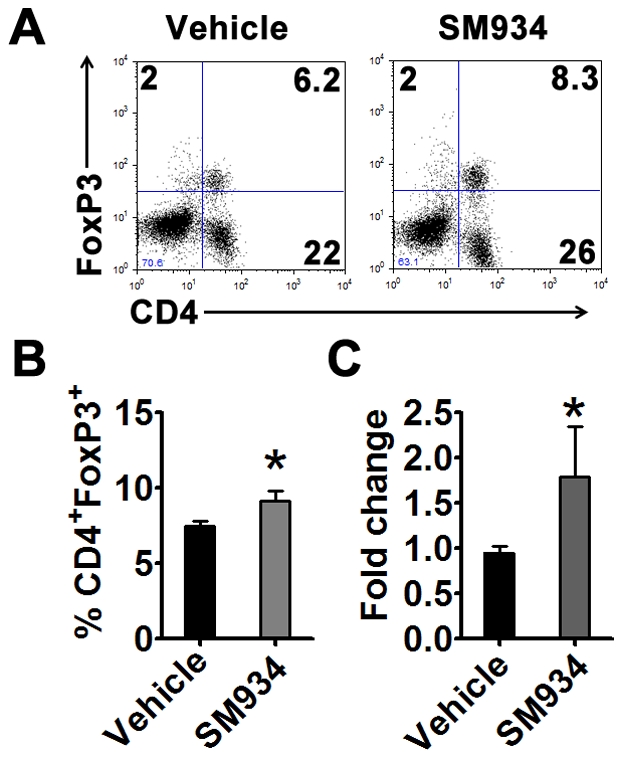
SM934 treatment induced the accumulation of Treg cells.At the termination of 3 months treatment, female NZB/W F1 mice in vehicle and SM934 (10 mg/kg) treated groups were randomly and averagely divided into 3 sub-groups. Spleens of each sub-group were pooled together. (A) Surface CD4 and intracellular FoxP3 expressions in splenocytes. (B) Statistical results of percentage of CD4+FoxP3+ population in splenocytes. (C) Real-time PCR analysis of FoxP3 mRNA expression in purified CD4+ T cells. Shown are mean ± SD, n = 3 in each treated group. * = P<0.05 versus vehicle.